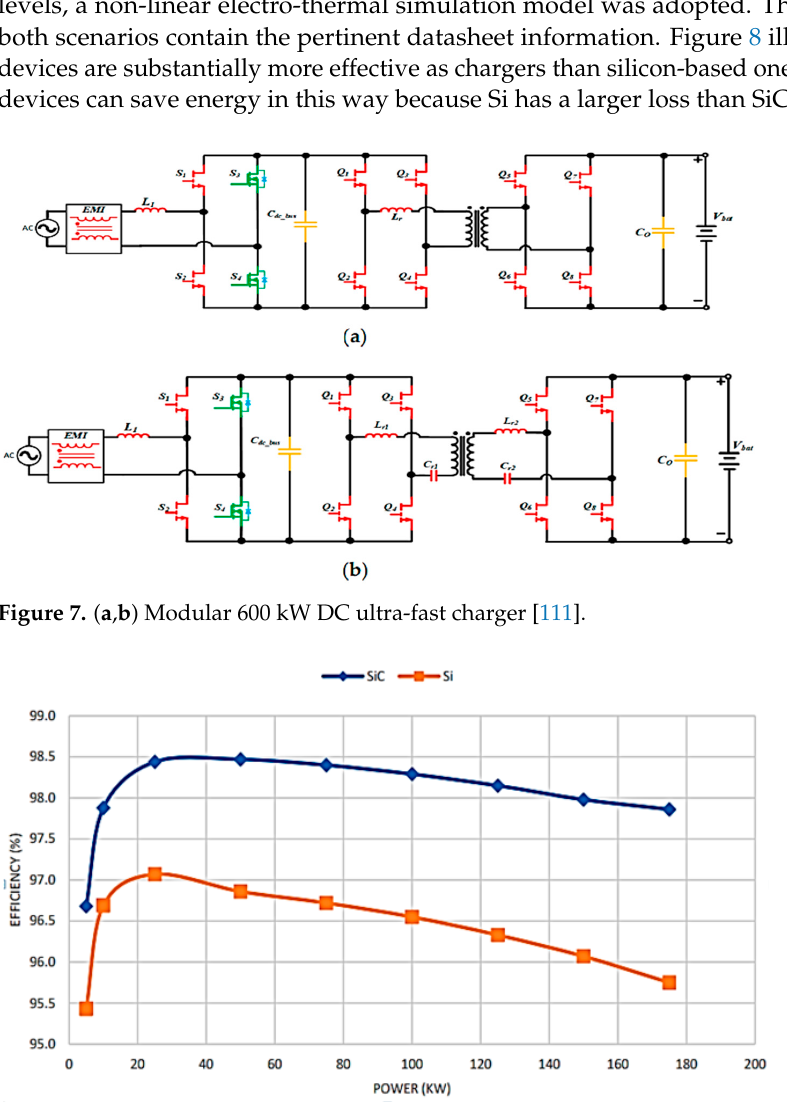
Figure 6. GaN-switch-based bidirectional OBC system topologies [107].